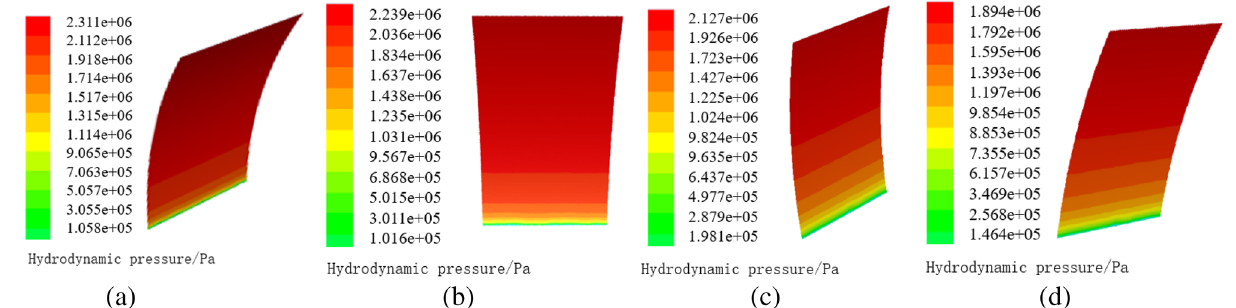
Figure 5. Distribution of hydrodynamic pressure on the surface of radial gate. ( a ) Hydrodynamic pressure distribution at 5 s, ( b ) Hydrodynamic pressure distribution at 10 s, ( c ) Hydrodynamic pressure distribution at 15 s, and ( d ) Hydrodynamic pressure distribution at 20